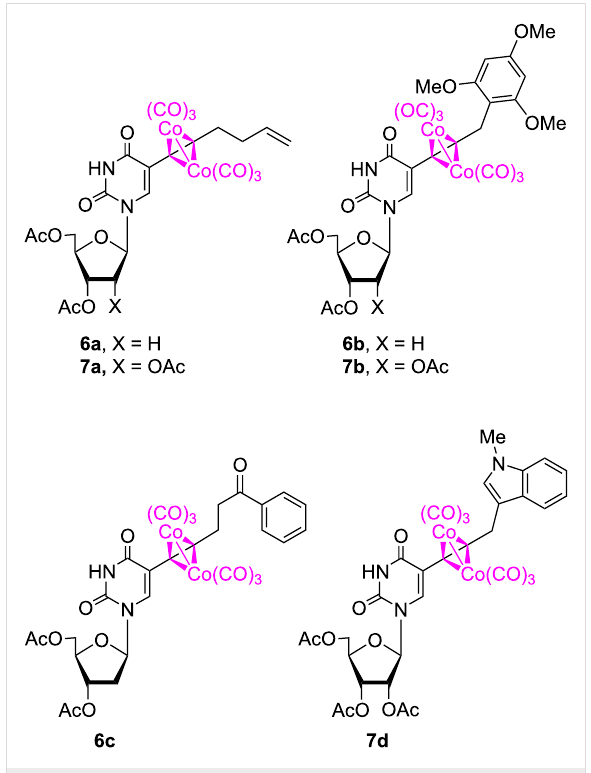
Figure 1: Structures of nucleosides 6 and 7 , products of the Nicholas